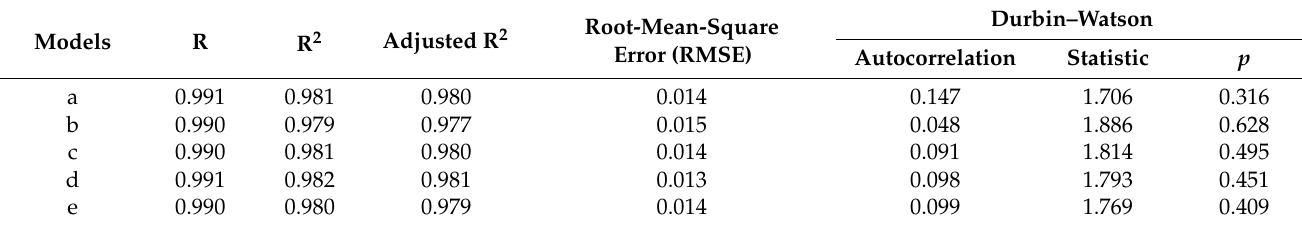
Table 2. Summary of multiple linear regression (MLR) prediction models for chlorophyll content of Astragalus seeds. Models